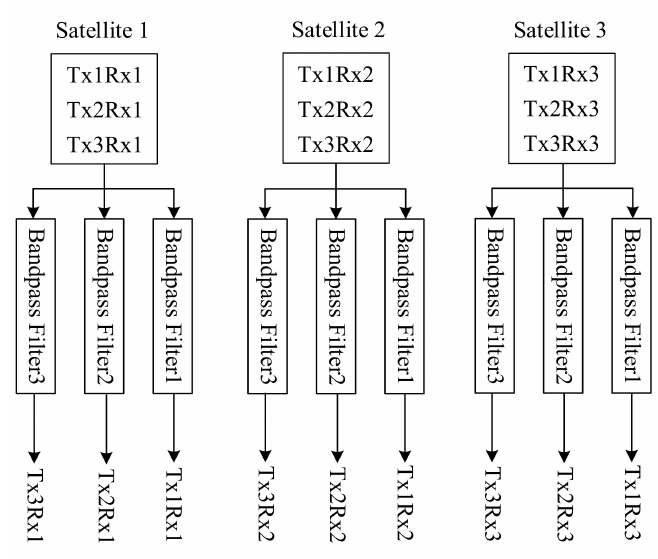
Figure 7. Signal